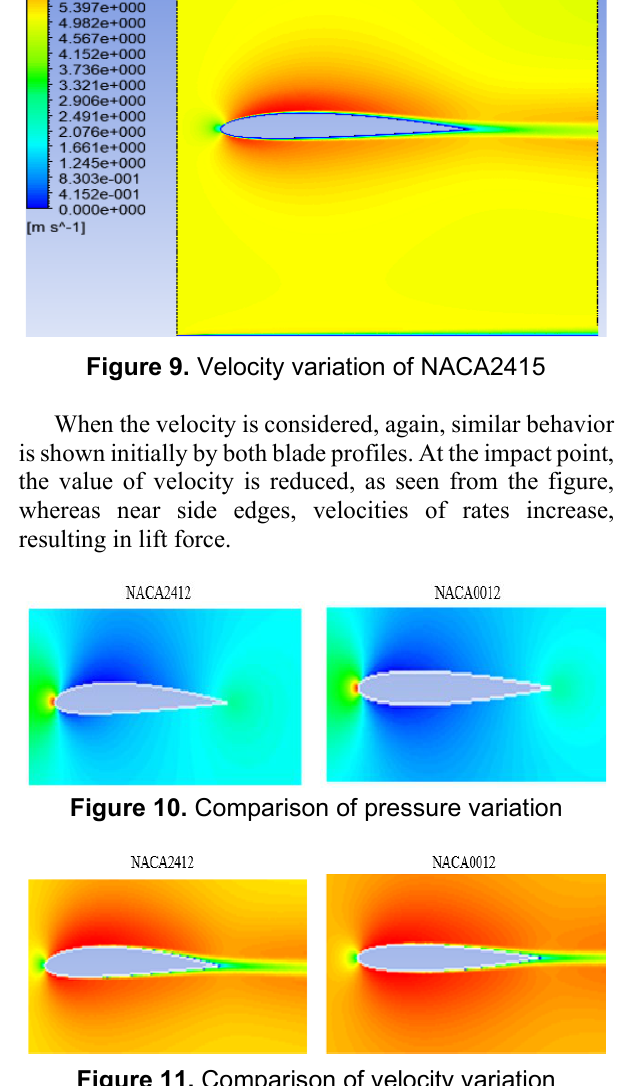
Figure 11. Comparison of velocity